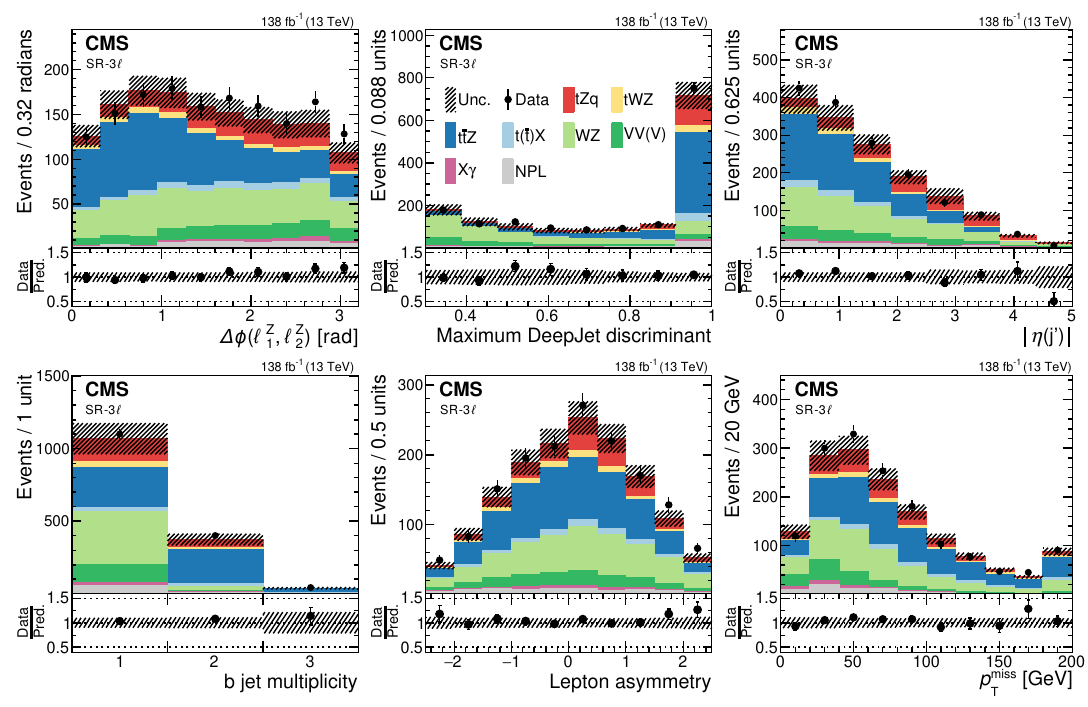
Figure 2 . Pre-fit data-to-simulation comparisons for several observables in the SR- 3 ‘ . From left to right and upper to lower, the distributions correspond to: the relative azimuthal angle ∆ φ between the two leptons from the Z boson decay; the maximum DeepJet discriminant among all selected jets; the absolute pseudorapidity of the recoiling jet; the b jet multiplicity; the lepton asymmetry; and p miss . The lower panels display the ratios of the observed event yields to their predicted values. T The NPL background is modeled with the procedure based on control samples in data described in section 6. The hatched band represents the total uncertainty in the prediction. Underflows and overflows are included in the first and last bins,